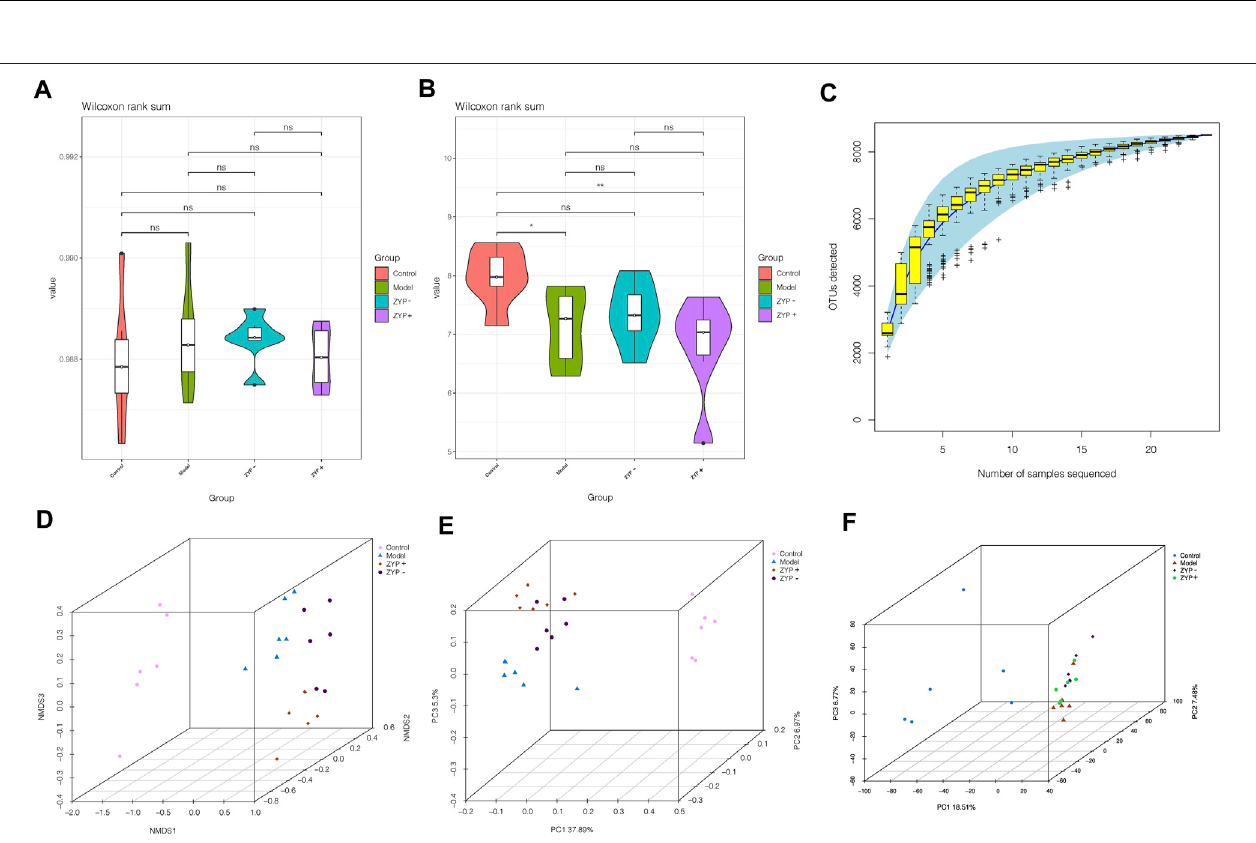
FIGURE 6 | Alpha and beta diversity analysis of the OTUs. (A) Good diversity analysis; (B) Shannon diversity analysis; (C) Curve of SAC; (D) NMDS analysis; (E) PCoA analysis; (F) PCA analysis.